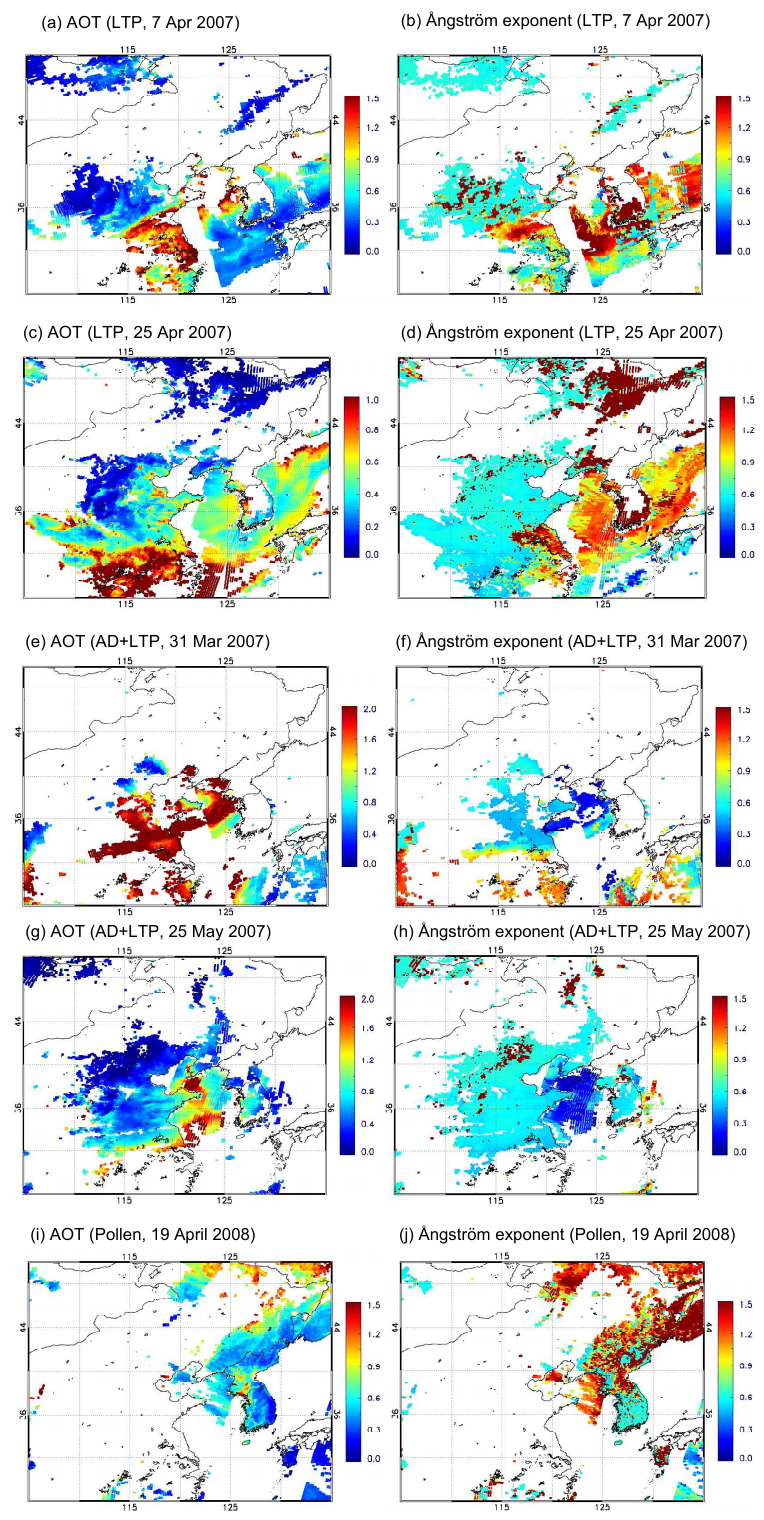
Fig. 5. MODIS aerosol optical thickness (AOT) and ˚Angstr¨om exponent during the selected days (7 April 2007 and 25 April 2007) of the LTP episodes (Fig. 5a–d). Values during the selected days of the AD+LTP (31 March 2007 and 25 May 2007) and pollen (19 April 2008) episodes are shown in Fig. 5e–h and Fig. 5i–j,